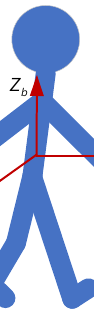
Figure 3. Results diagram of the triaxial acceleration signal. The output frequency range of the built-in accelerometer of the smartphone is generally 15 – 200 Hz [29]. In this study, the output frequency of the mobile phone is set to 50 Hz. The coordinate axis of the accelerometer deviates from the walking components of pedestrians, as shown in Figure 2, due to the various postures in which pedestrians hold their phones. In order to eliminate the influence of the directional changes of the smartphone, the resultant acceleration is used to calculate the acceleration norm, denoted as a , by computing the Euclidean norm: